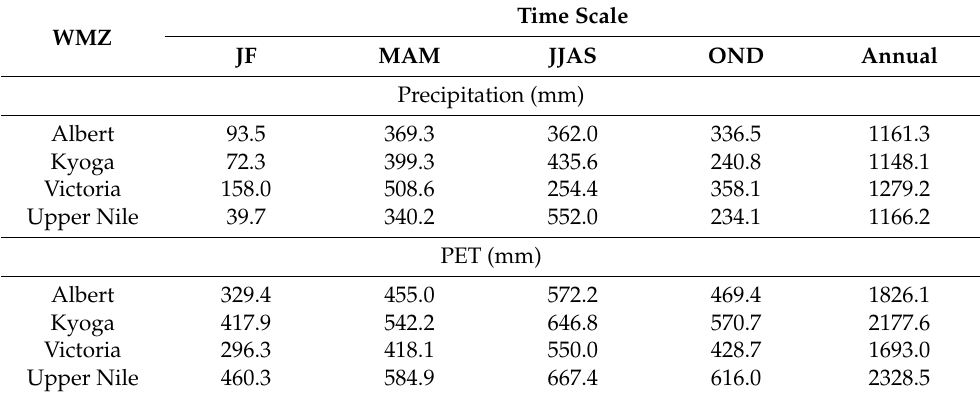
Table 3. Long-term mean of historical precipitation and PET for the four WMZs. Time Scale WMZ JF MAM JJAS OND Annual Precipitation